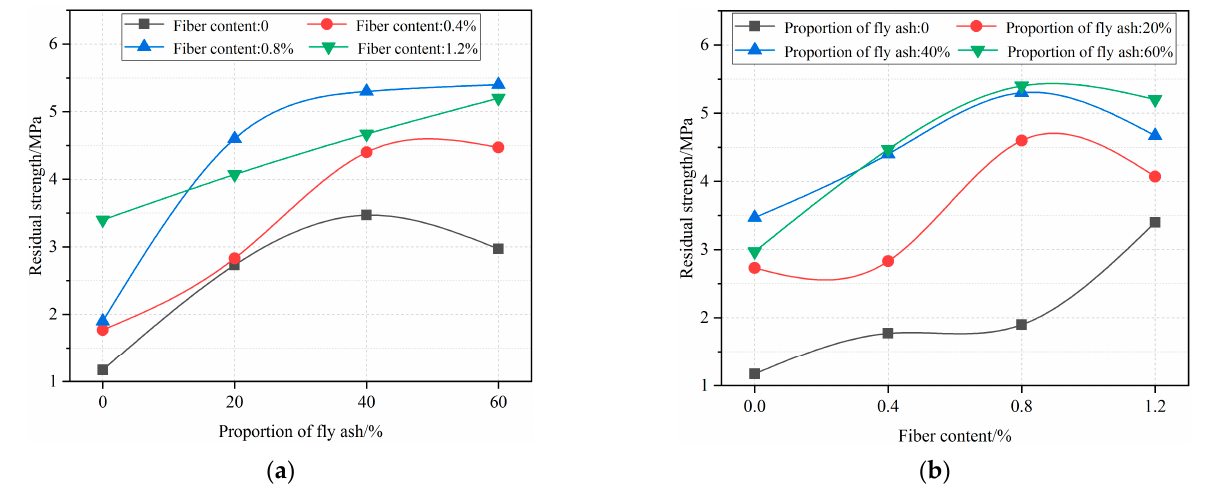
Figure 8 . Influence of the FA ratio ( a ) and SF content ( b ) on the residual strength. Figure 8. Influence of the FA ratio ( a ) and SF content ( b ) on the residual